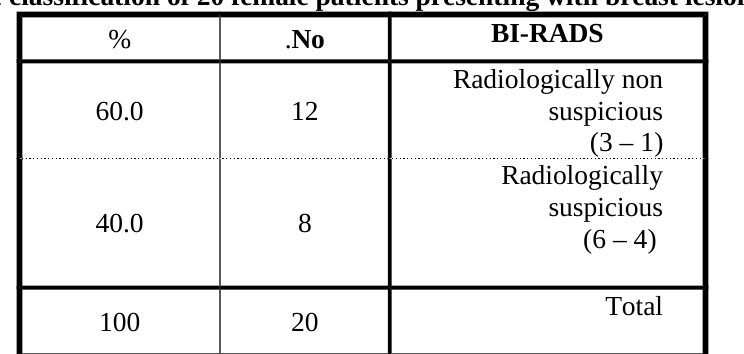
Table (3): The classification of 20 female patients presenting with breast lesions